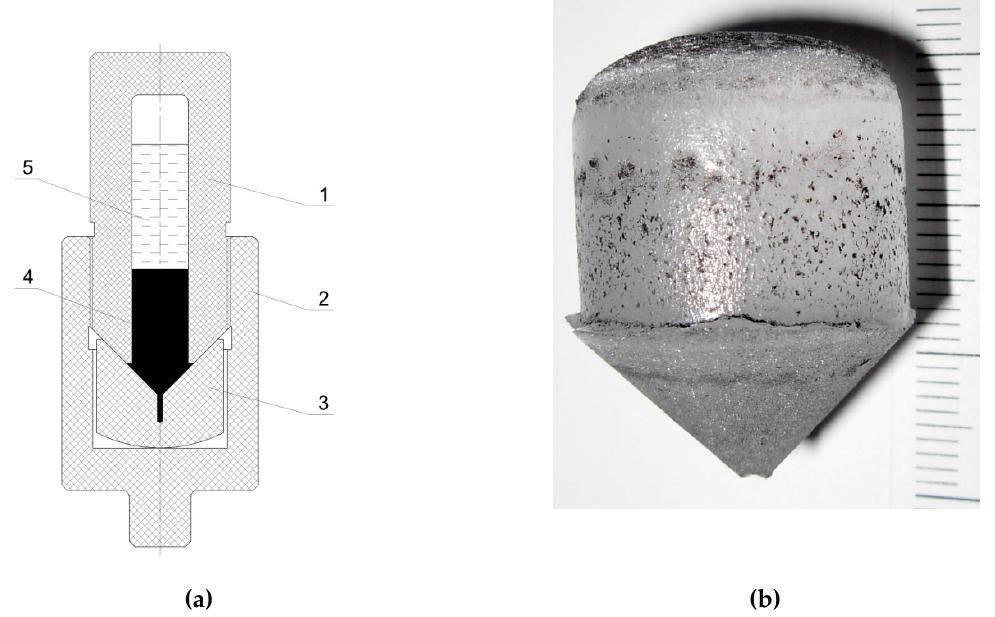
Figure 2. ( a ) Schematic drawing of a self-sealing graphite crucible: 1 – growth container; 2 – base; 3 – internal insert with the seed channel; 4 – crystal; 5 – melt; (b) As-grown ScF 3 crystal.